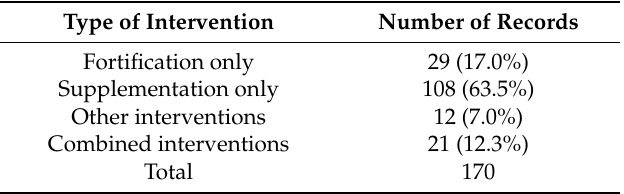
Figure 1. Flowchart of review selection process. CDSR: Cochrane Database of Systematic Reviews. Of the 170 included SRs and SR protocols, the majority addressed food fortification ‐ only ( n = 29, 17.0%) or micronutrient supplementation ‐ only interventions ( n = 108, 63.5%) (Table 1). Table 1. Number of systematic reviews and systematic review protocols addressing micronutrient deficiencies by type of intervention.